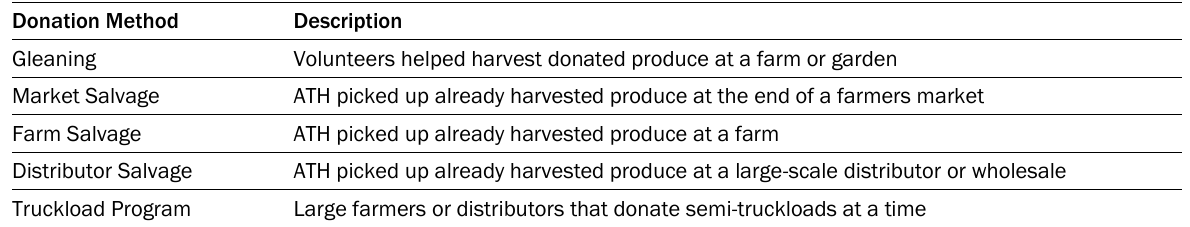
Table 1. Farmer Donation Methods Donation